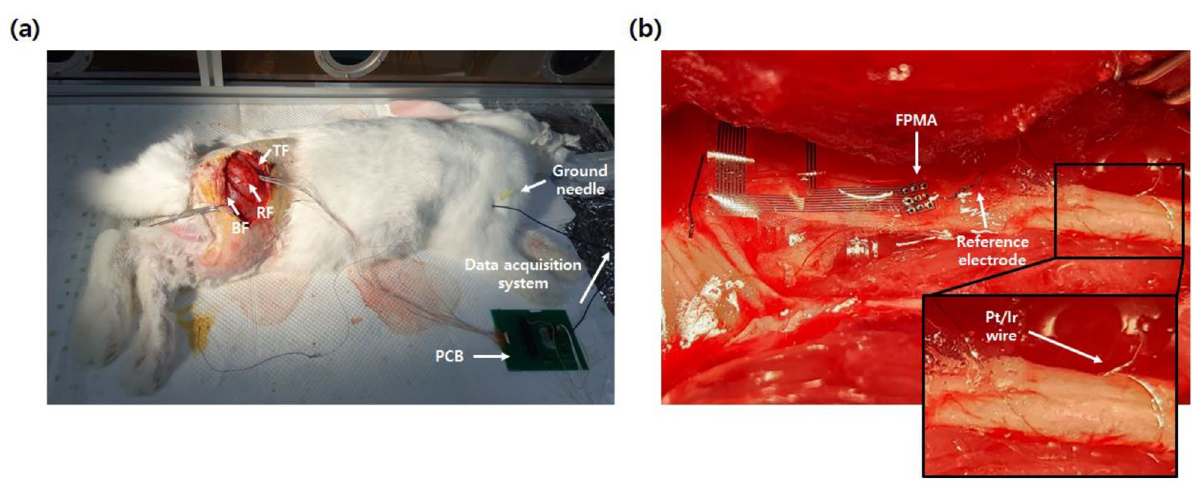
Fig. 2 Experimental setup for acute recording from the sciatic nerve in a rabbit. (a) An FPMA was inserted between BF and RF muscles and the cable came out through the space between RF and TF muscles. The wires were connected to the data acquisition system through a PCB. A ground needle was inserted into the skin of the forelimb (BF: biceps femoris muscle. RF: rectus femoris muscle. TF: tensor fasciae latae muscle). (b) A magnified view of the FPMA implanted on the sciatic nerve. A flat electrode based on the parylene-C cable and a Pt/Ir wire were used as reference